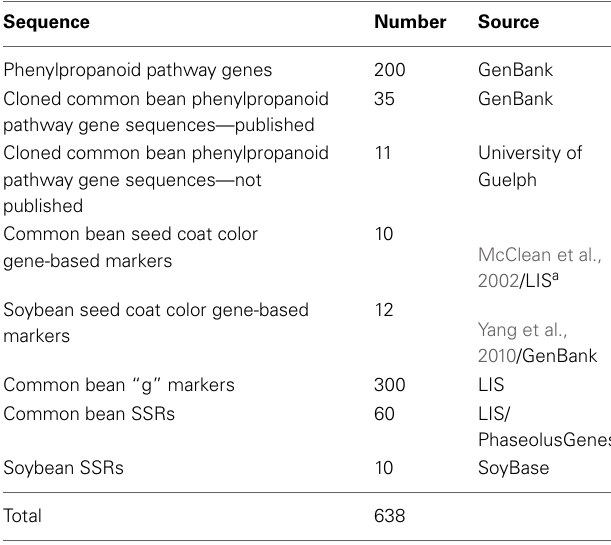
Table 1 | Phenylpropanoid pathway gene and marker sequences used in BLAST